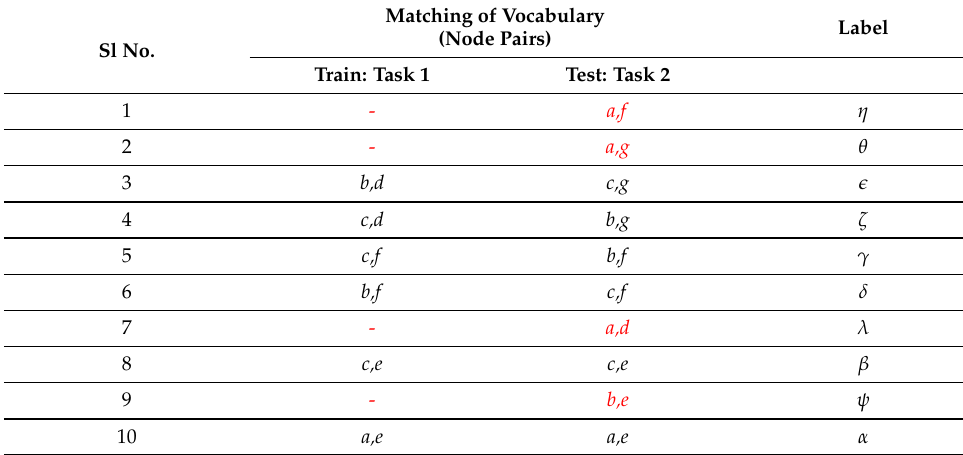
Figure 18. Joint vocabulary from the model M 1 . Table 2. Activated node pairs (labels) and values.